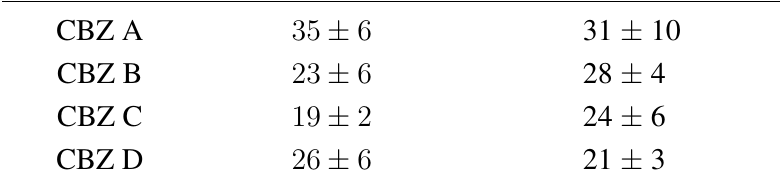
Table 1. Inflection points (IP) in DIDR profiles of untreated and recrystallized CBZ